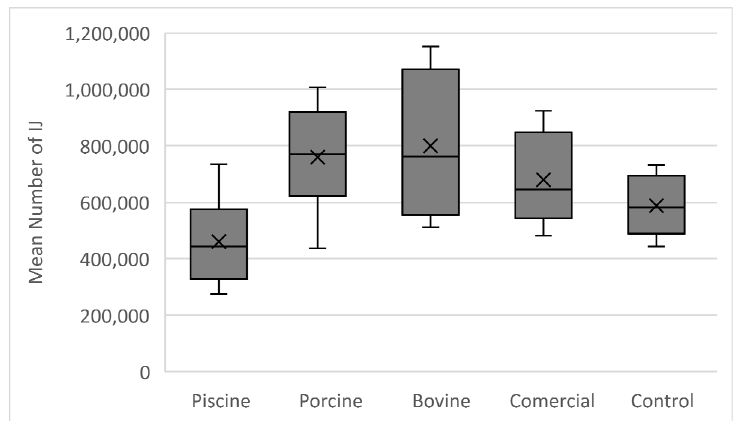
Figure 3. Mean (± SE) number of IJ recorded per 1.8 g of waxworms emerging in the various bio ‐ Figure 3. Mean ( ± SE) number of IJ recorded per 1.8 g of waxworms emerging in the various plastic treated microcosms (n = 6, error bars represent standard deviation). bioplastic treated microcosms (n = 6, error bars represent standard